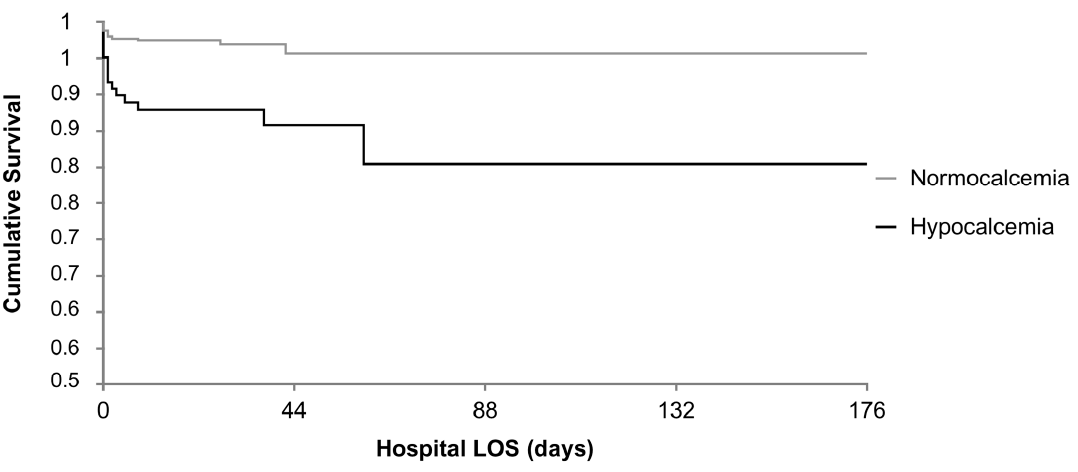
Figure 3. Kaplan–Meier Survival Rates. Hypocalcemic vs. Normocalcemic